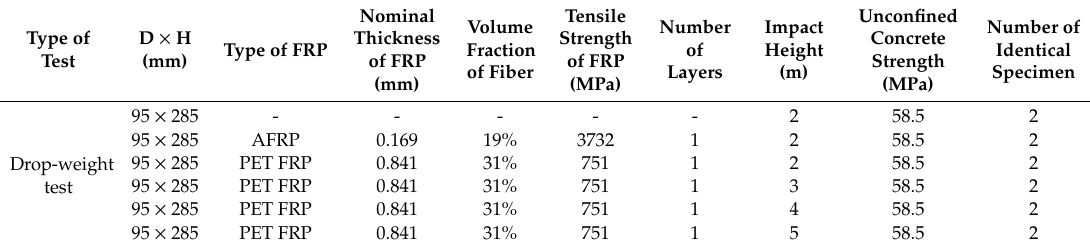
Table 2. Summary of specimens for the drop-weight impact test.